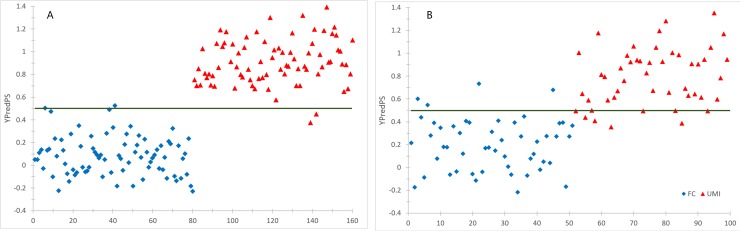
Classification result by OPLS-DA model.A. training set; B. validation set.